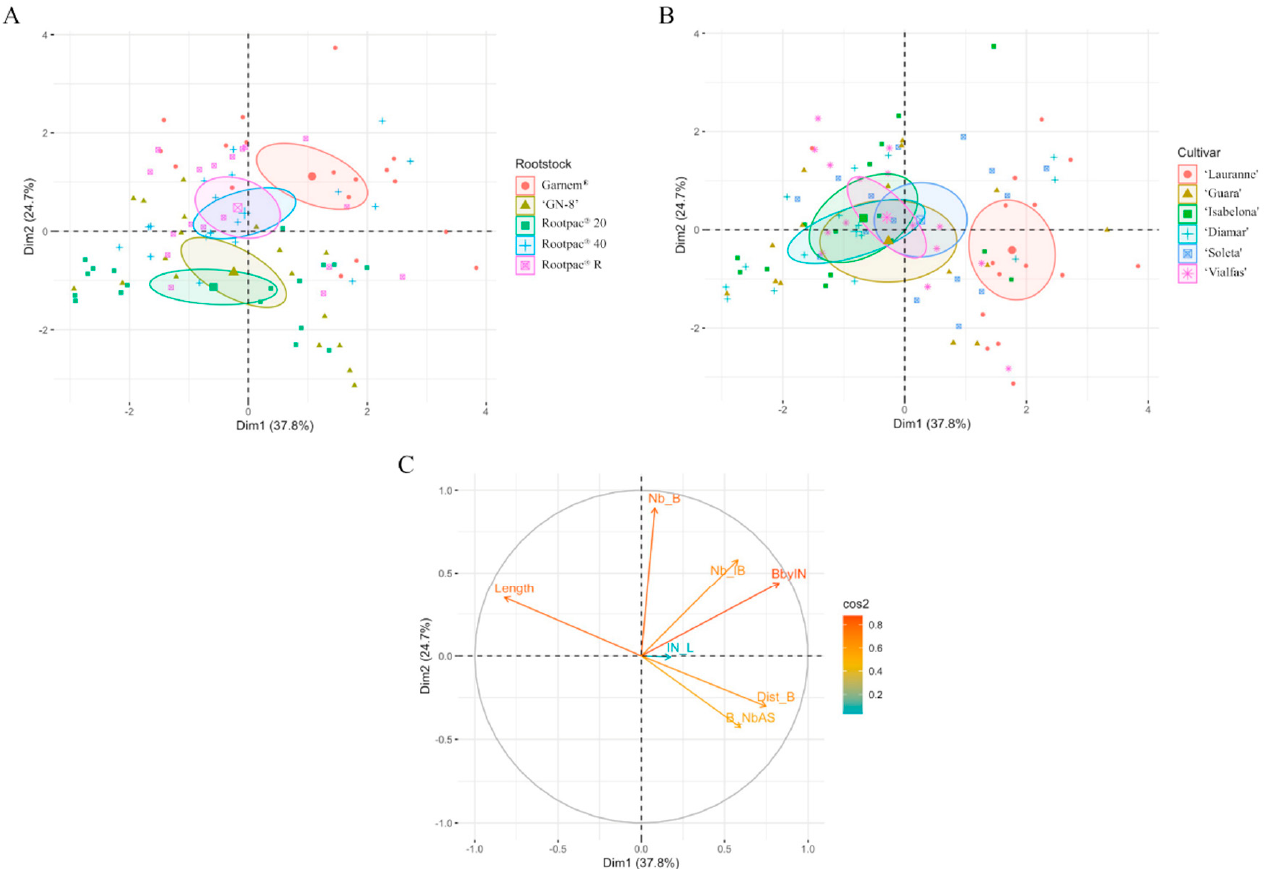
Figure 2. Principal component analysis (PCA) of seven non-redundant variables of 30 almond scion–rootstock combinations. ( a ) Distribution of scion–rootstock combinations classified by rootstock choice as a categorical variable with the first two components (Dim1 and Dim2), with concentration ellipses for each rootstock; ( b ) Distribution of scion–rootstock combinations classified by cultivar choice as a categorical variable with the first two components (Dim1 and Dim2), with con- centration ellipses for each cultivar; ( c ) Distribution of the seven non-redundant variables with the first two components (Dim1 and Dim2). Contribution of each parameter to the components is colored from blue to red. Data were collected from 2-year-old trees. Refer to Table 1 for abbreviations.